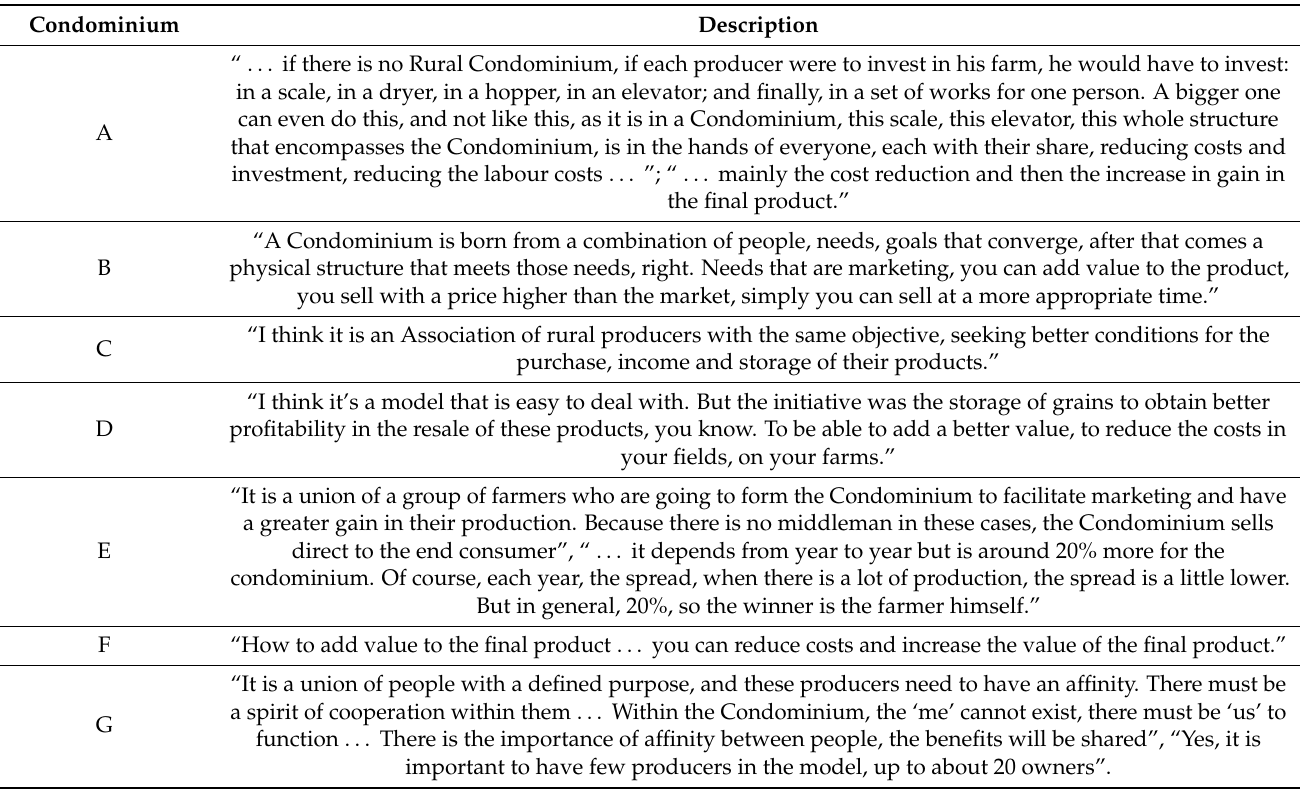
Table 1. Interviewees’ statements about the Condominiums of Rural Warehouses